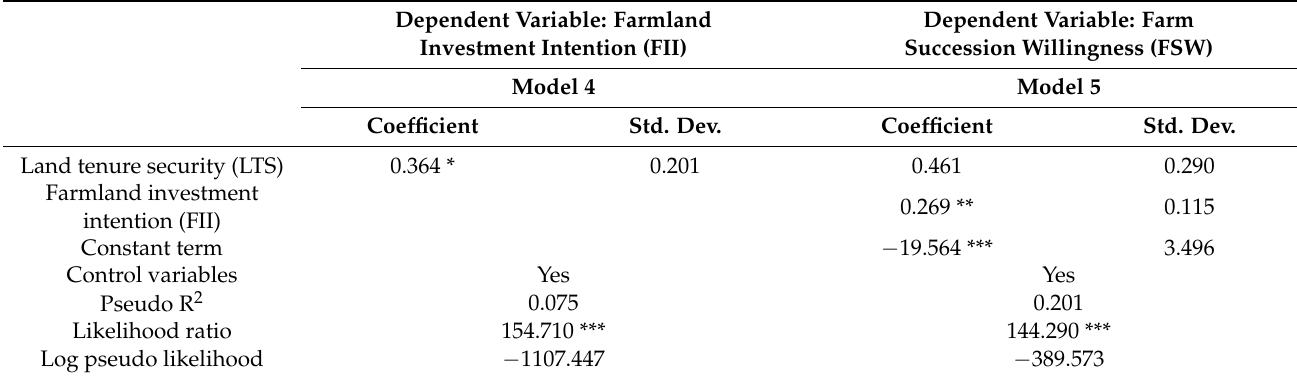
Table 3. Mediating effect of LTS on